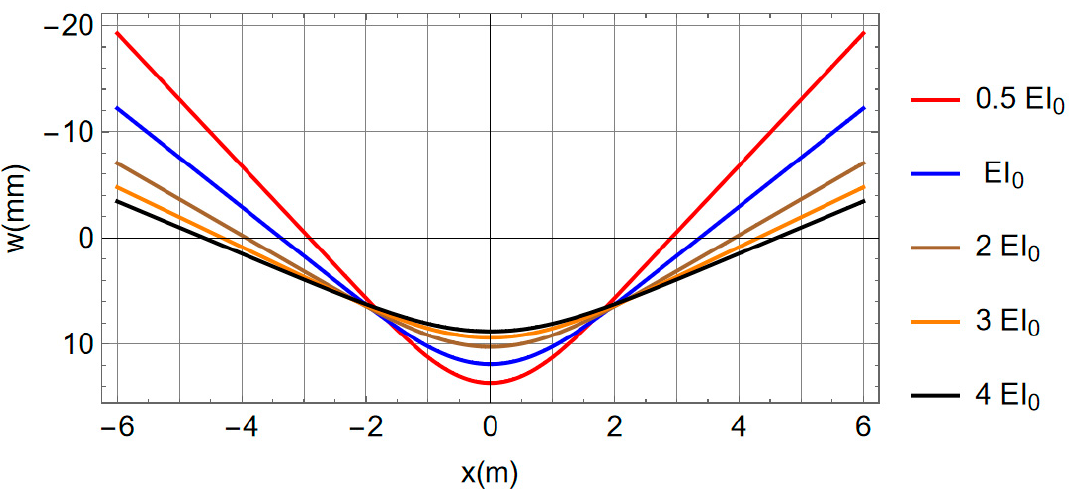
Figure 15. The beam deflection at different stiffness levels (Case 2).